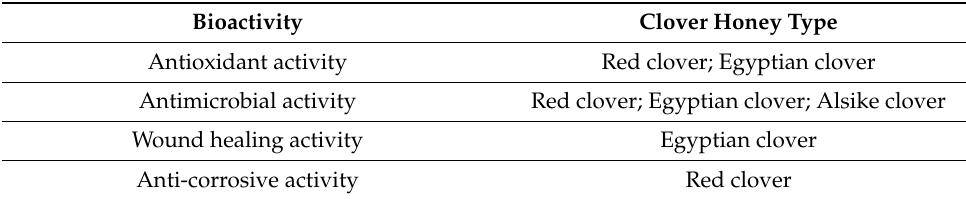
Table 6. Bioactivities of various clover honeys. Bioactivity Clover Honey